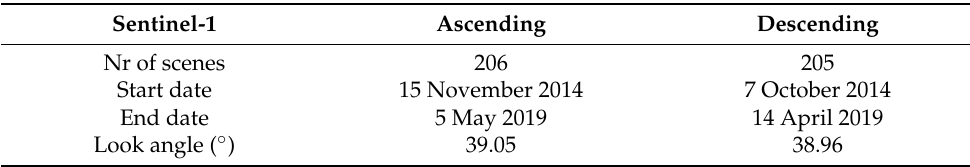
Table 1. Description of the analyzed